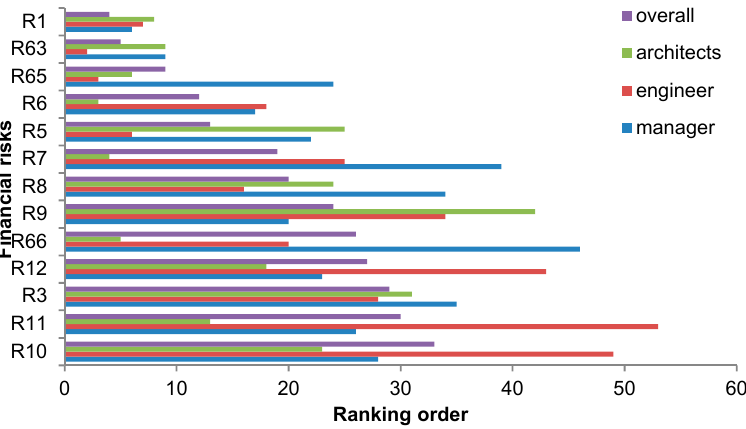
Figure 4. Ranking the financial risk factors impacting on the project value.